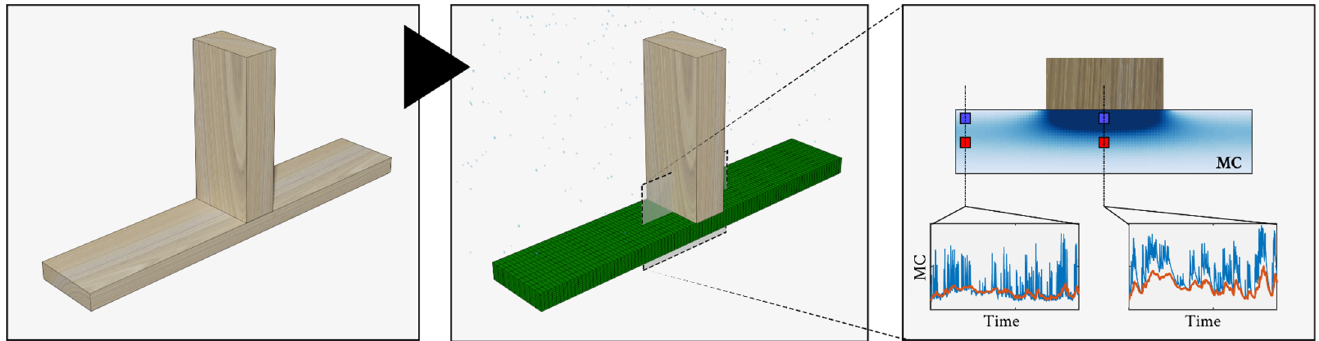
Figure 2. Spatial moisture distribution in the presence of a moisture trap design. Left: Example of a moisture trapping design; Middle: Segmentation of the bottom board to render moisture content (MC) distribution; Right: 2D cut-out of distribution of MC and the variable readings at different locations (red and blue squares—four points total).